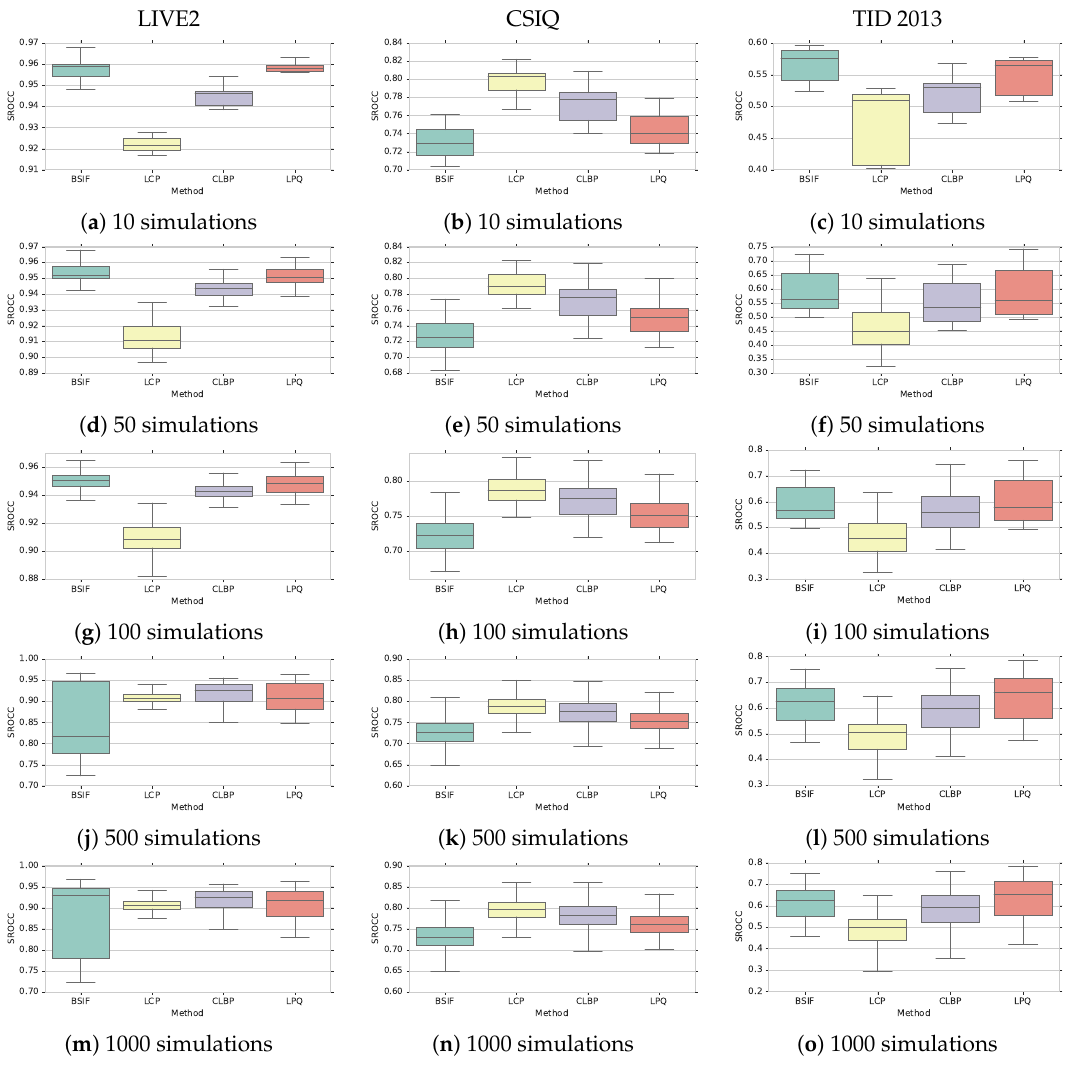
Figure 28. Stability of the mean SROCC over the simulations after 10, 50, 100, 500, and 1000 simulations using different